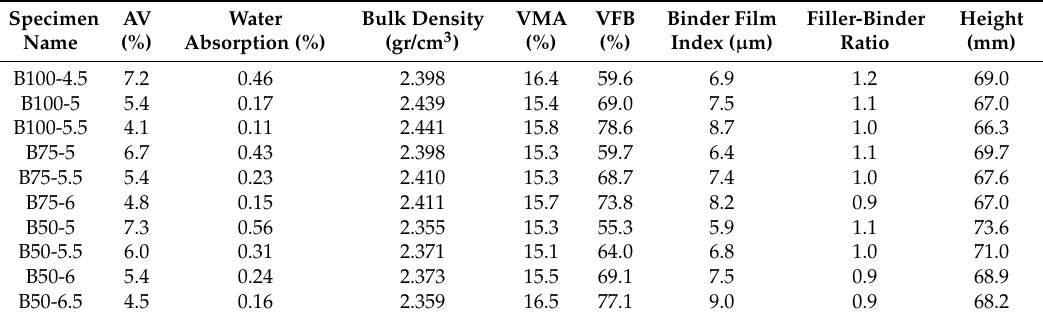
Table 7. Volumetric properties of asphalt mixtures.